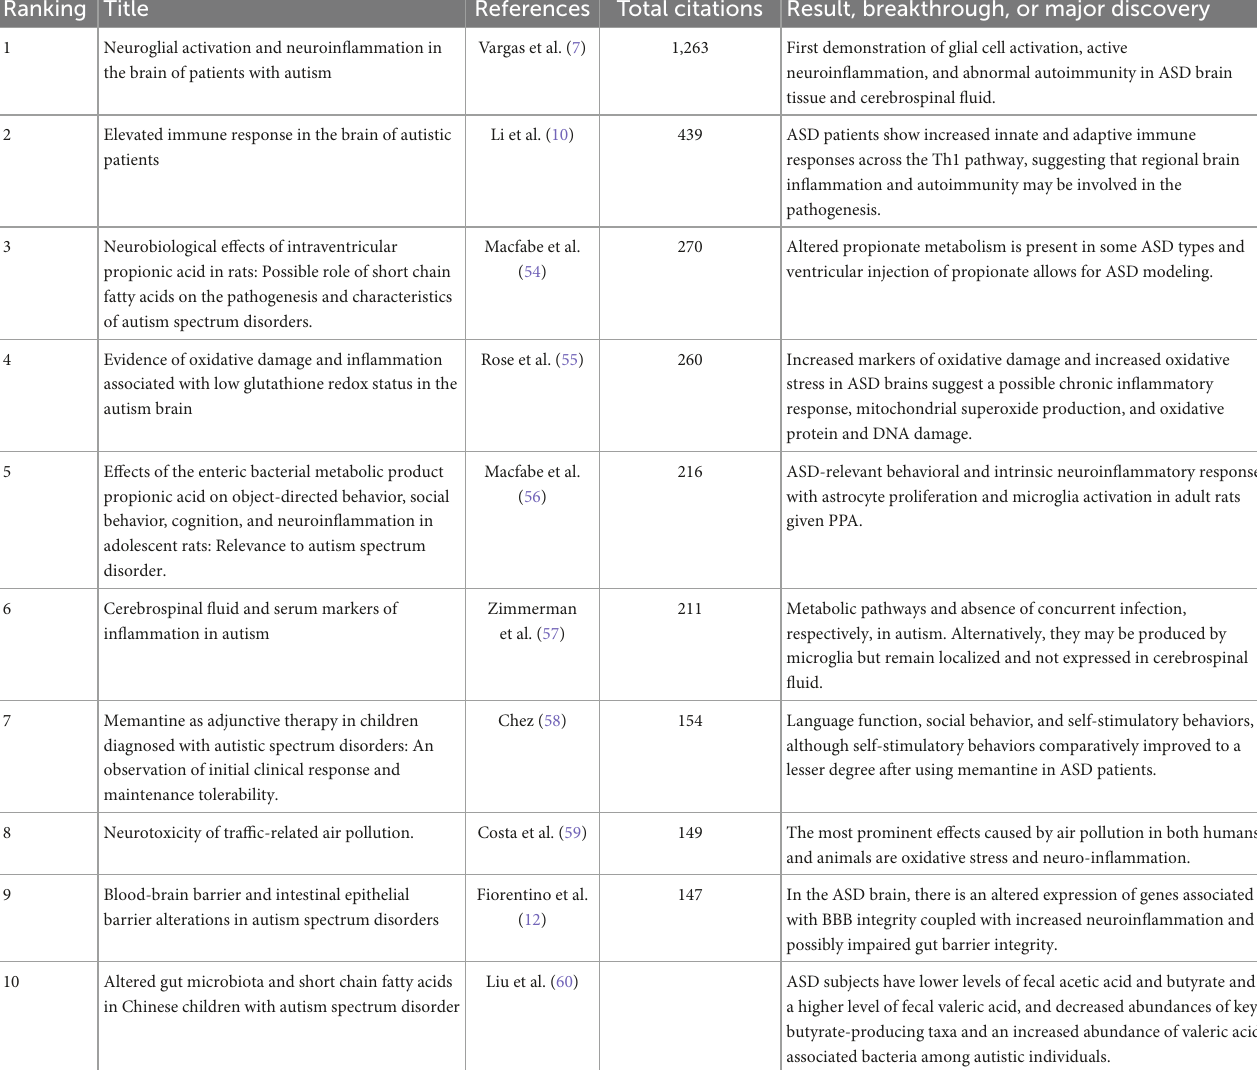
TABLE 4 The basic information of most accumulatively cited 10 experimental papers in the